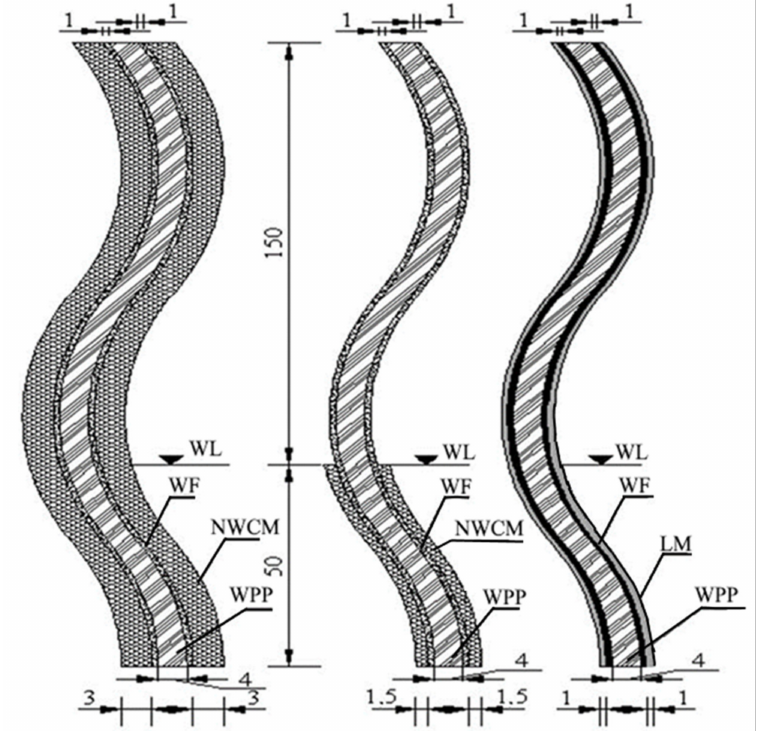
Figure 2. Compositions of the plates of the packing material. LM: Linen material, NWCM: Non- woven caulking material, WF: Wood fiber, WL: Water level, WPP: Wavy polymer